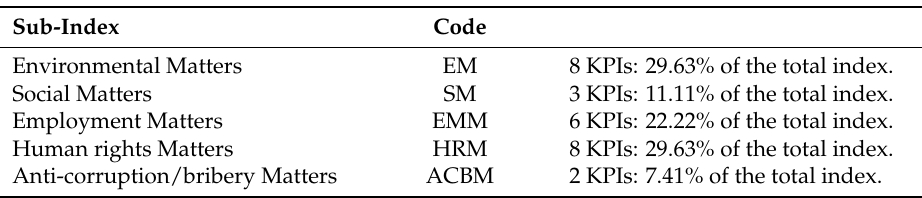
Table 2. Information included in the non-financial